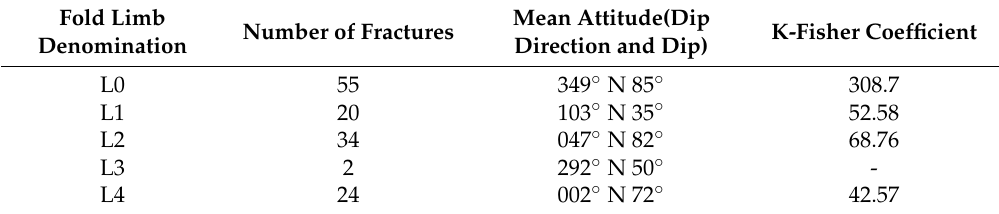
Table 11. Features of fracture set K4 determined in the different fold limbs.